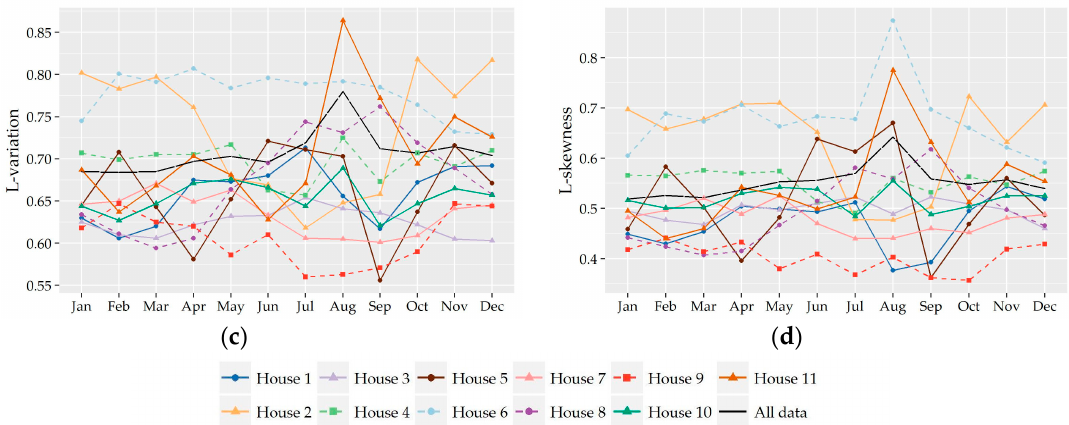
Figure 2. 15-min scale: Variation per month of the probability of no demand ( a ), mean value ( b ), L- variation ( c ), and L-skewness ( d ) of the 15-min nonzero demand records analyzed.